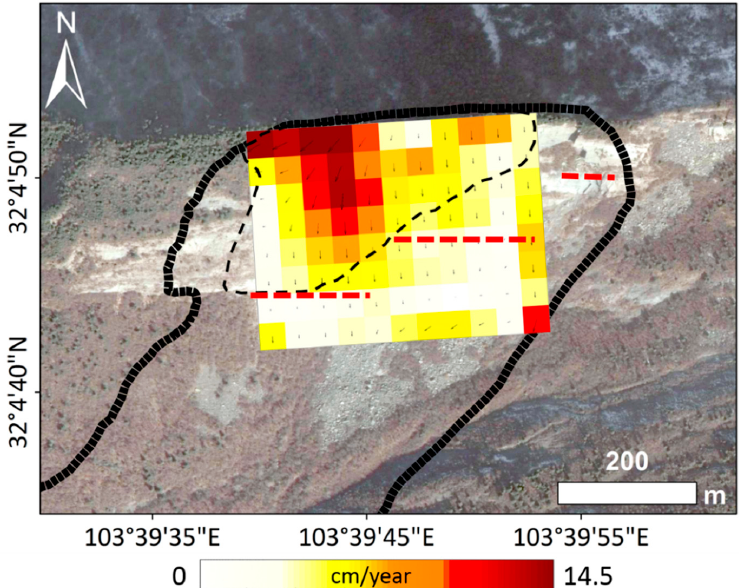
Figure 7. Slip distribution at the landslide basal plane, in which the arrows inside each block represents the direction of the shear movement. The bold black line represents the failure boundary of the landslide, and the finer black dotted line represents the boundary of the area with obvious terrain change. The red dashed lines represent the locked section (based on Wang et al. [5]).